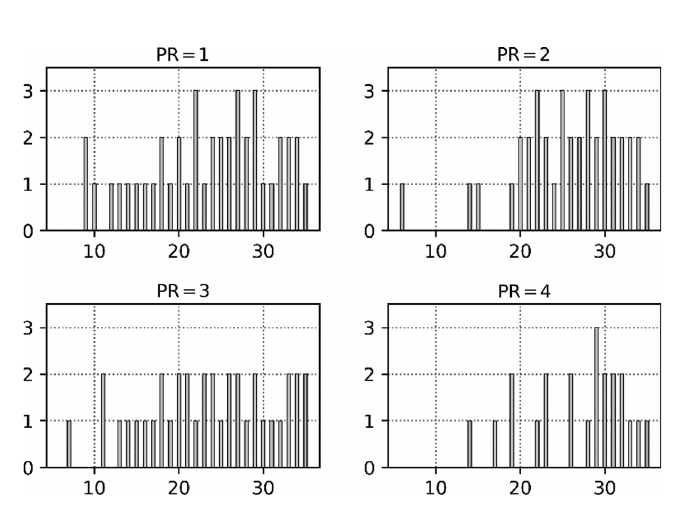
Fig. 3: Number of different recommendations vs given number of total points for different